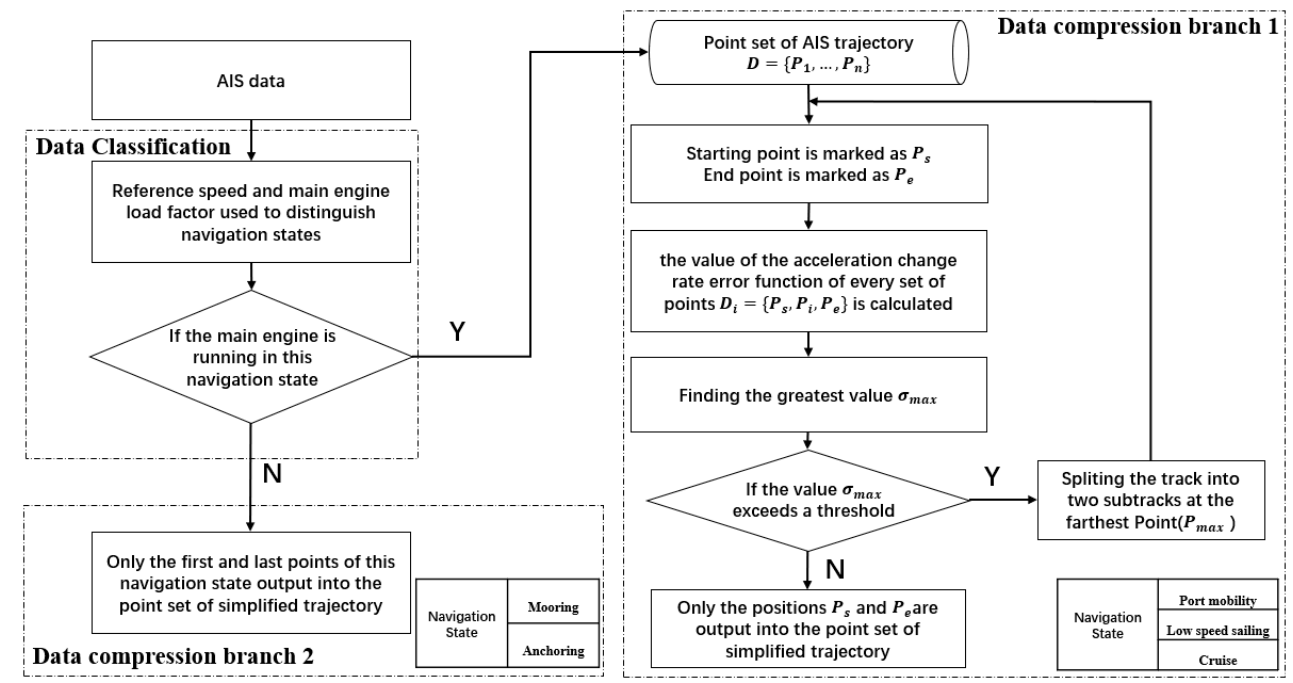
Figure 1. Framework diagram of the simplified algorithm. First, the AIS data are classified according to the navigation status, and only the first and last trajectory points of the trajectory are retained for the part of the data where the main engine is not running (see data compression branch 2). Then, the maximum value σ max of the acceleration rate of change function in all intermediate trajectory points P i is calculated for the part the data where the main engine running, and the result is compared with the set threshold value to determine whether to retain or delete it (see data compression branch 1).